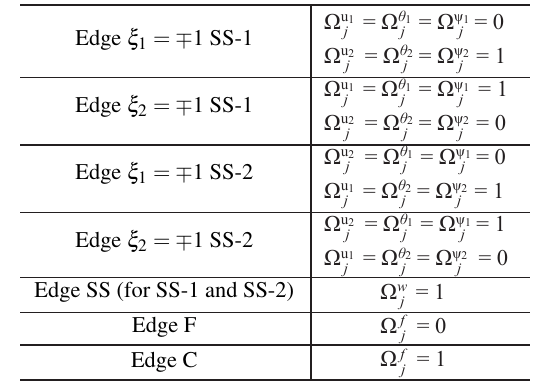
Table A.8. Exponents for the classical geometric bound- Table A.1. Exponents for the classical geometric boundary